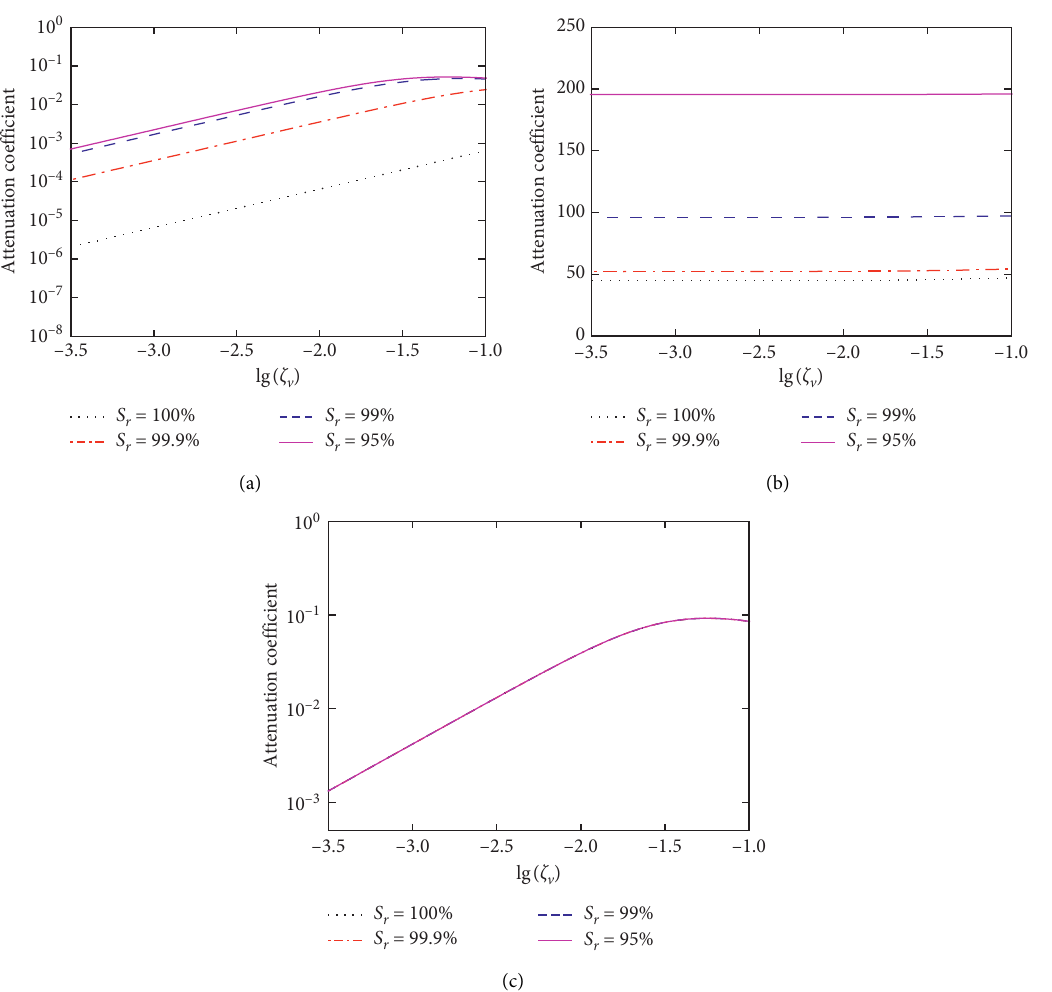
Figure 5: Variation of attenuation coefficients of P1, P2, and S waves with damping coefficient ξ 0.00.20.40.60.81.0